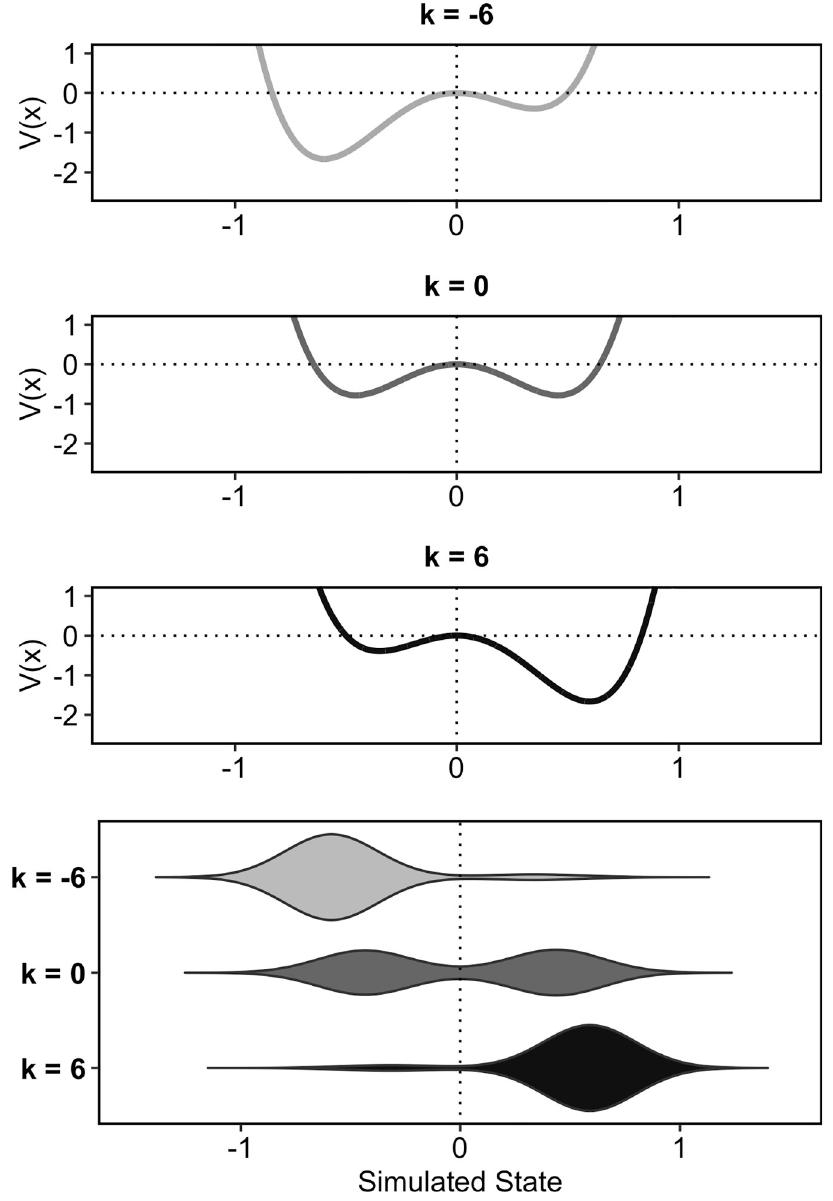
Fig 13. Illustration of the simulation with different values for k. The first three panels from the top show the potentials for different values of the control parameter k. The lower panel gives the simulation results for these parameter